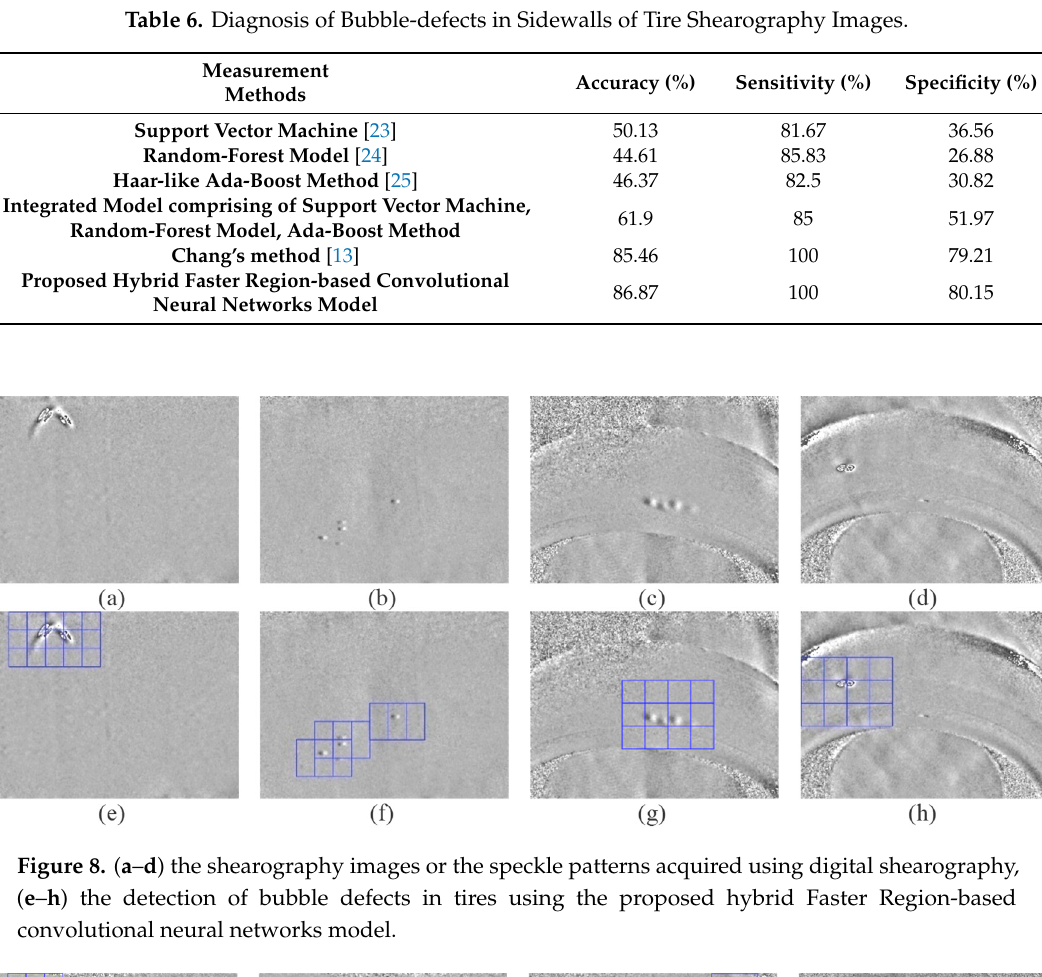
Table 6. Diagnosis of Bubble-defects in Sidewalls of Tire Shearography Images.